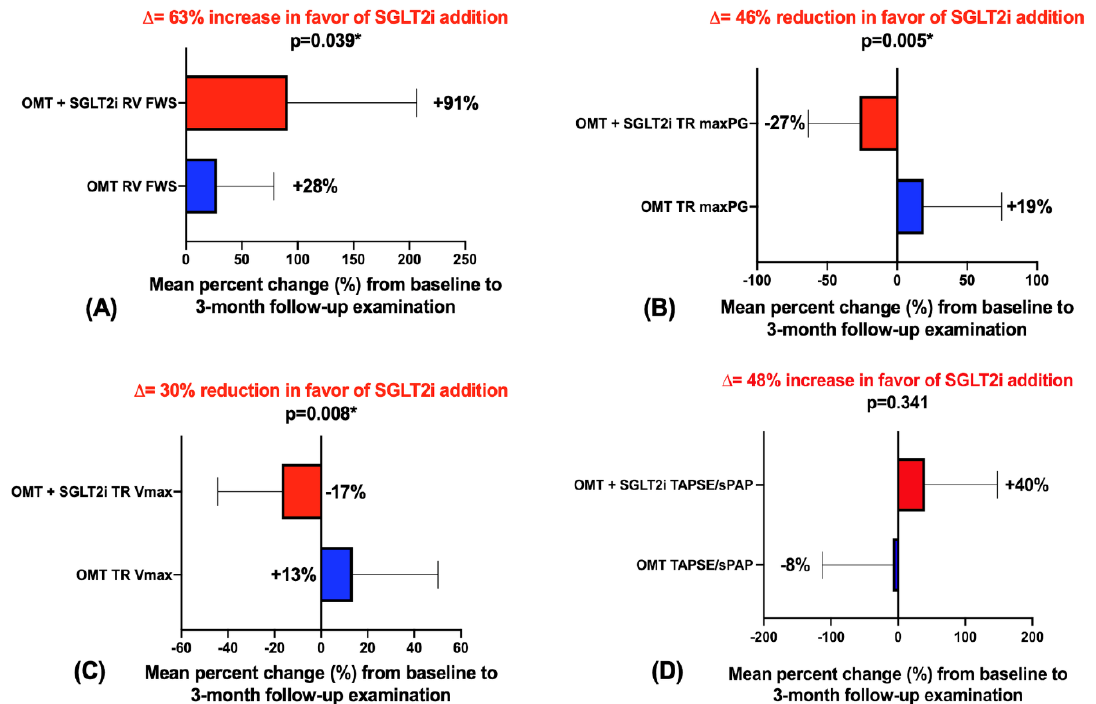
Figure 1. Mean percent change (%) from baseline to 3-month follow-up; red—OMT+SGLT2i group, blue—OMT control group; ( A )—mean percent change in right ventricular free wall strain between groups from baseline to 3mFU; ( B )—mean percent change in TR maximal pressure gradient between groups from baseline to 3mFU; ( C )—mean percent change in maximal TR velocity between groups from baseline to 3mFU; ( D )—mean percent change in TAPSE/SPAP ratio between groups from baseline to 3mFU. * Two-tailed significance values ( p ) were reported in all instances, while the results that reached p < 0.05 were considered to be statistically